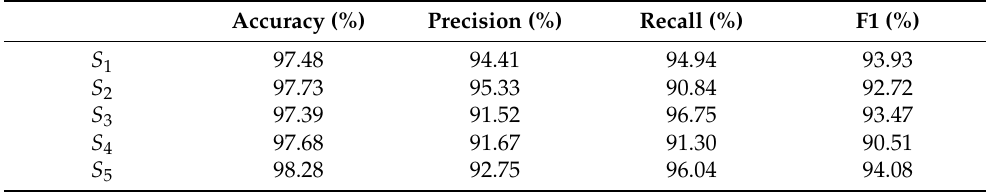
Figure 11. Accuracies of two data sets at different thresholds. ( a ) UCI data set, and ( b ) PAMAP2 data set. Table 4. Experimental results of five groups of test samples in the UCI data